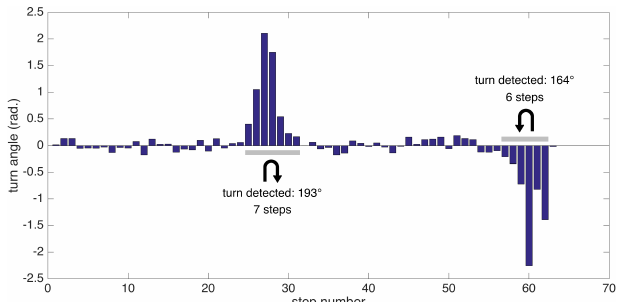
Figure 11. Turn angles for individual steps and detected substantial turns.